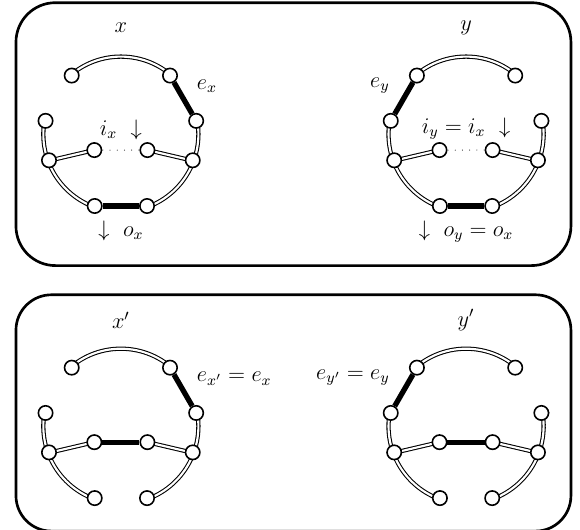
Figure 9. Case 4. a .ii, case 4. b .ii, and case 4. c .ii, when o x Figure 9: Case 4. a .ii, case 4. b .ii and case 4. c .ii, when o x Figure 9: Case 4. a .ii, case 4. b .ii and case 4. c .ii, when o x